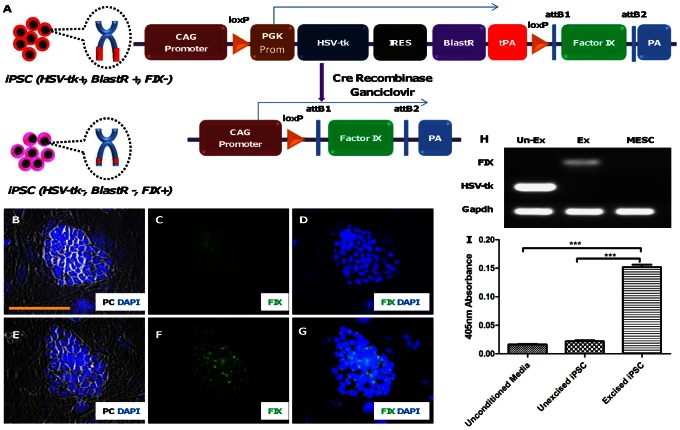
Temporal induction of transgenic FIX expression in iPSCs utilizing the Cre-loxP/HSV-tk/gan selection strategy.Schematic diagram for the vector pCag-lox-PGK-HSV-tk-BlastR-tpA-lox-FIX pre- and post-excision (A). In the unexcised form of the vector HSV-tk and blasticidin resistance protein is expressed from the PGK promoter. On Cre recombinase-mediated excision of the loxP flanked cassette (bottom half of the schematic) the CAG promoter (cytomegalovirus (CMV) enhancer fused to the chicken beta-actin promoter) starts expressing FIX as the tpA stop sequence is lost after the excision event. Both pre- and post-excision iPSC colonies were immunostained with FIX antibody and the nuclear stain DAPI. Phase contrast image of a pre- (B) and post-excision (E) iPSC colony merged with DAPI. Factor IX immunostaining for a pre-excision iPSC colony show only background staining (C) while that of a post-excision iPSC colony show punctate staining (F). FIX staining of a pre-excision (D) and post-excision (G) iPSC colony merged with DAPI staining image. RT-PCR for FIX and HSV-tk was done for pre- and post-excision states (H). HSV-tk was expressed only in unexcised state and FIX was expressed only in excised state. Gapdh was used as the house keeping PCR control. Mouse ES cell D3 line (MESC) was used as the negative control for the experiment. Chromogenic assay to measure the functional activity of the FIX released in the media was done for both the unexcised and excised iPSCs (I). Unconditioned media was used as a negative control. The absorbance of the chromogenic assay product at 405 nm for the media conditioned by excised iPSCs was found to be highly significant (p≤.001, n = 3).